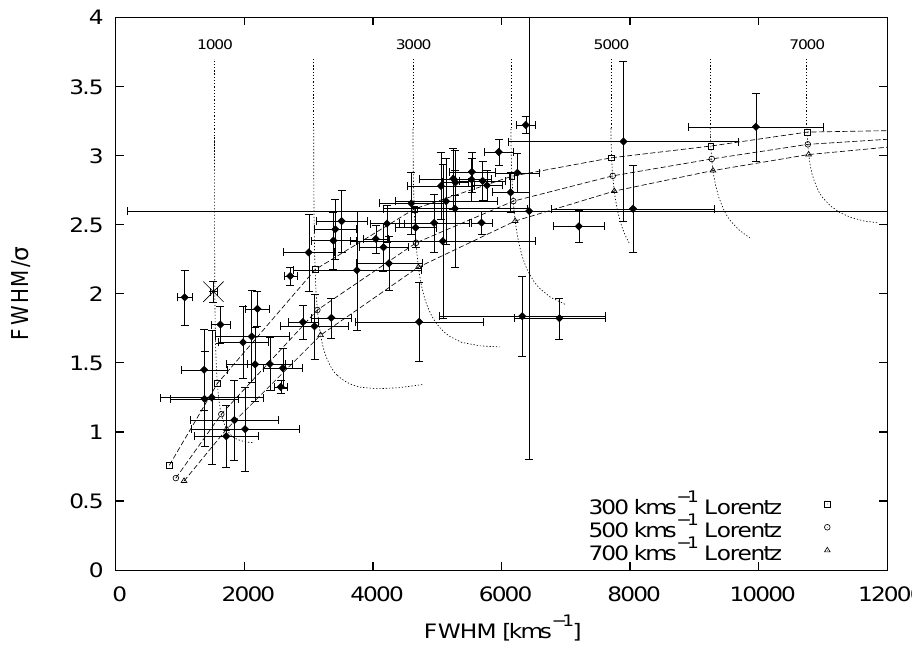
Fig. 2. The observed H (cid:12) line-width ratios FWHM/ (cid:27) line versus their FWHMs from Peterson et al. (2004). Shown are only those measurements that were regarded as being reliable by the authors. The dashed curves show theoretical line-width ratios of rotational line broadened Lorentzian profiles; the FWHMs are 300 km/s (squares), 500 km/s (circles) and 700 km/s (triangles). The associated rotation velocities range from 1000 to 7000 km/s (curved dotted lines, from left to right) (Kollatschny & Zetzl